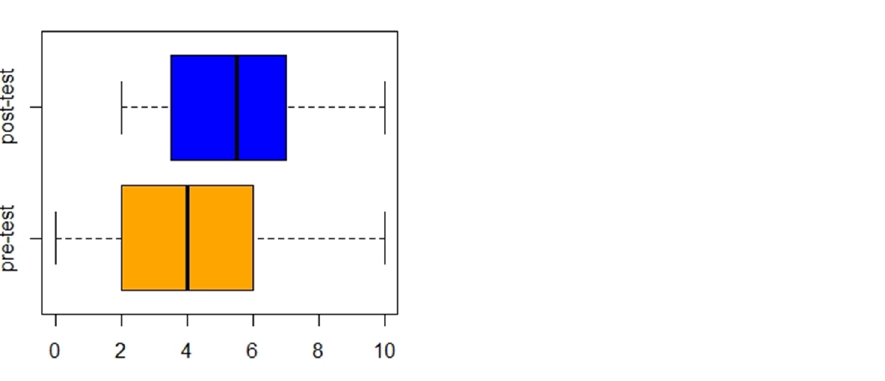
Figure 2. Boxplot graph representing the pupils’ scores in the pre- and post-test of the pantomime intervention. Table 8. Pupils’ performance on nouns and verbs for the pre- and post-test of the pantomime intervention.